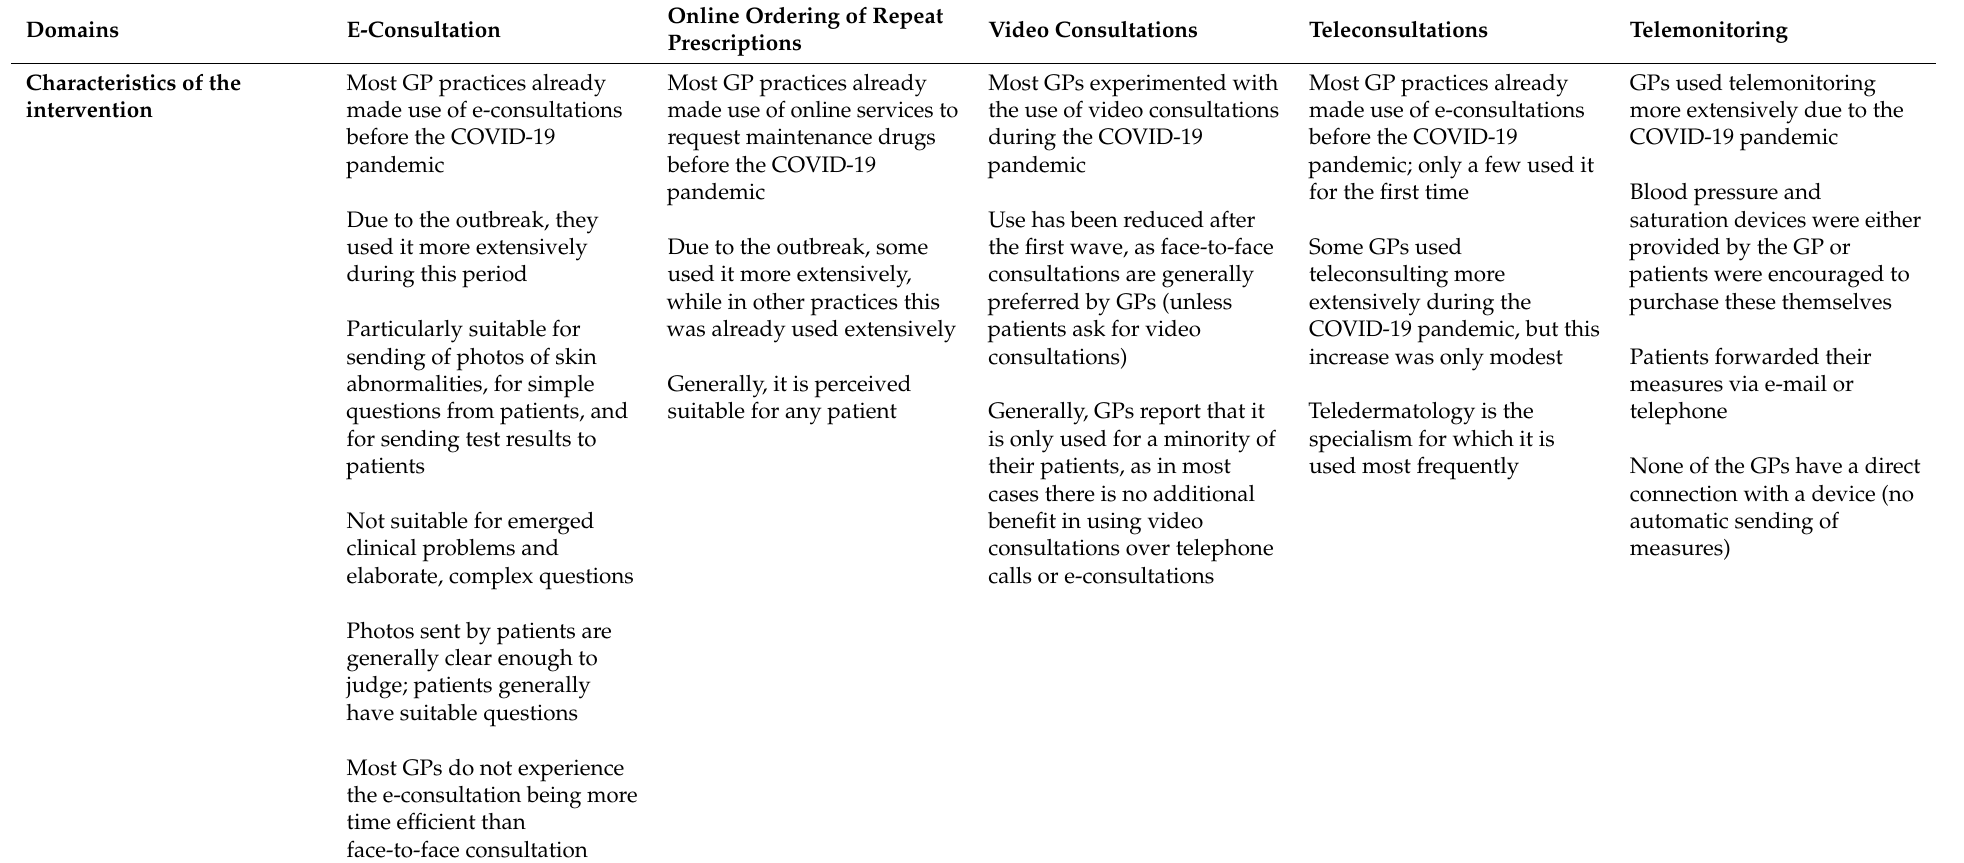
Table 1. Interview results structured according to the Consolidated Framework for Implementation Research (CFIR) domains, categorized by e-health